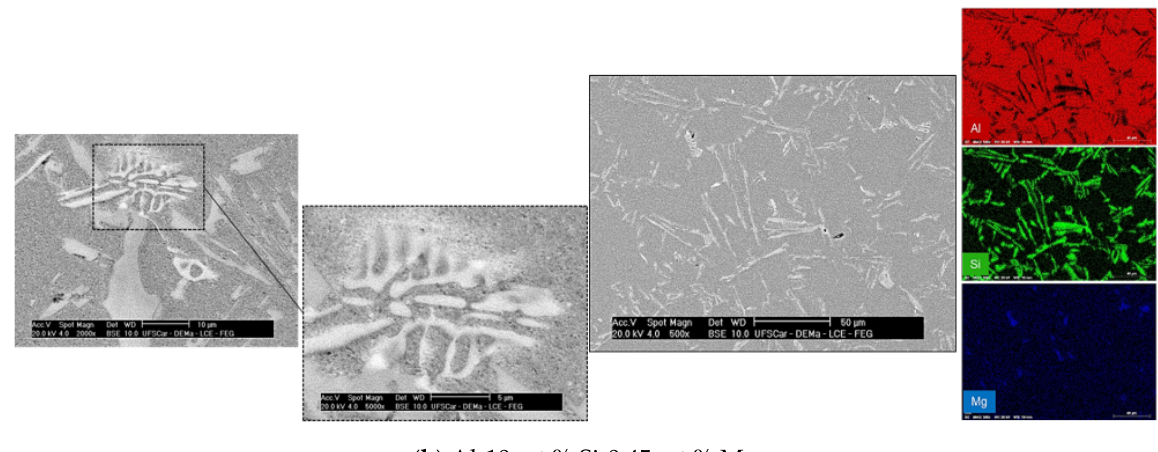
Figure 7. SEM images showing the formed phases, details with greater magnification and color mapping of the elements Al, Si, and Mg: ( a ) Al-10 wt.% Si-1 wt.% Mg and ( b ) Al-10 wt.% Si-0.45 wt.% Mg.